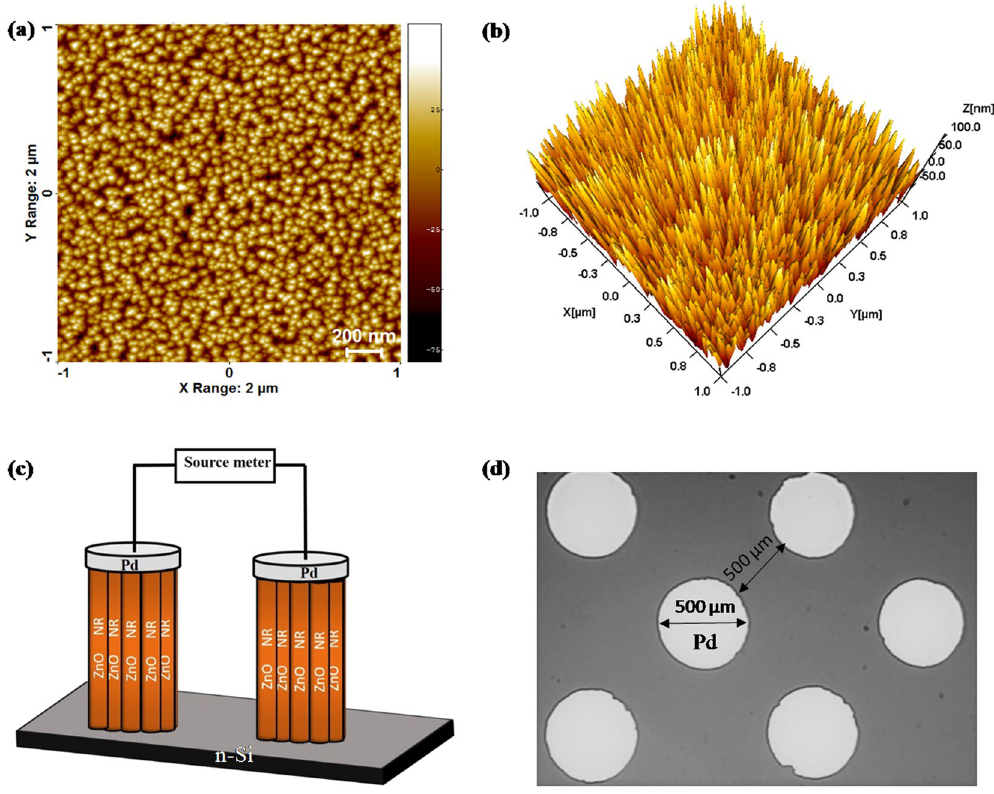
Figure 1. ( a,b ) 2-D and 3-D AFM images of ZnO NRs; ( c,d ) The schematic diagram and optical microscope image of the